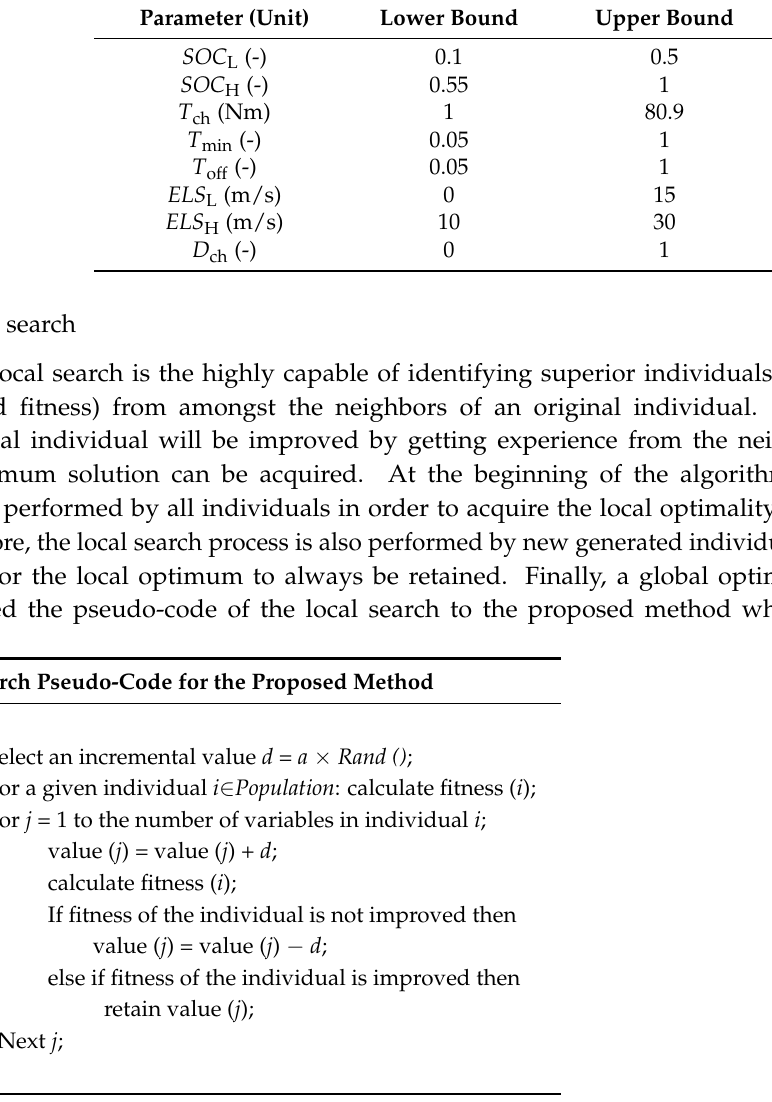
Table 3. Range of the parameters of the EACS constraints for the proposed method. Parameter (Unit) Lower Bound Upper Bound SOC L (-)